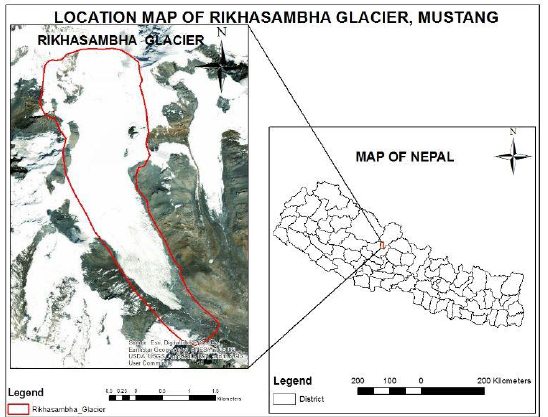
Figure 1. Study Area (Rikhasambha Glacier, Nepal)